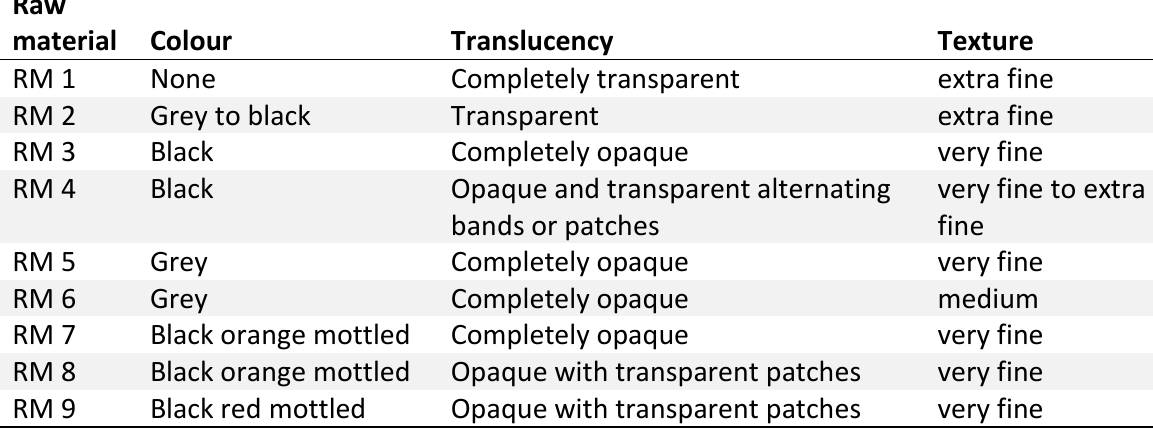
Table 1. Macroscopic raw material classification for